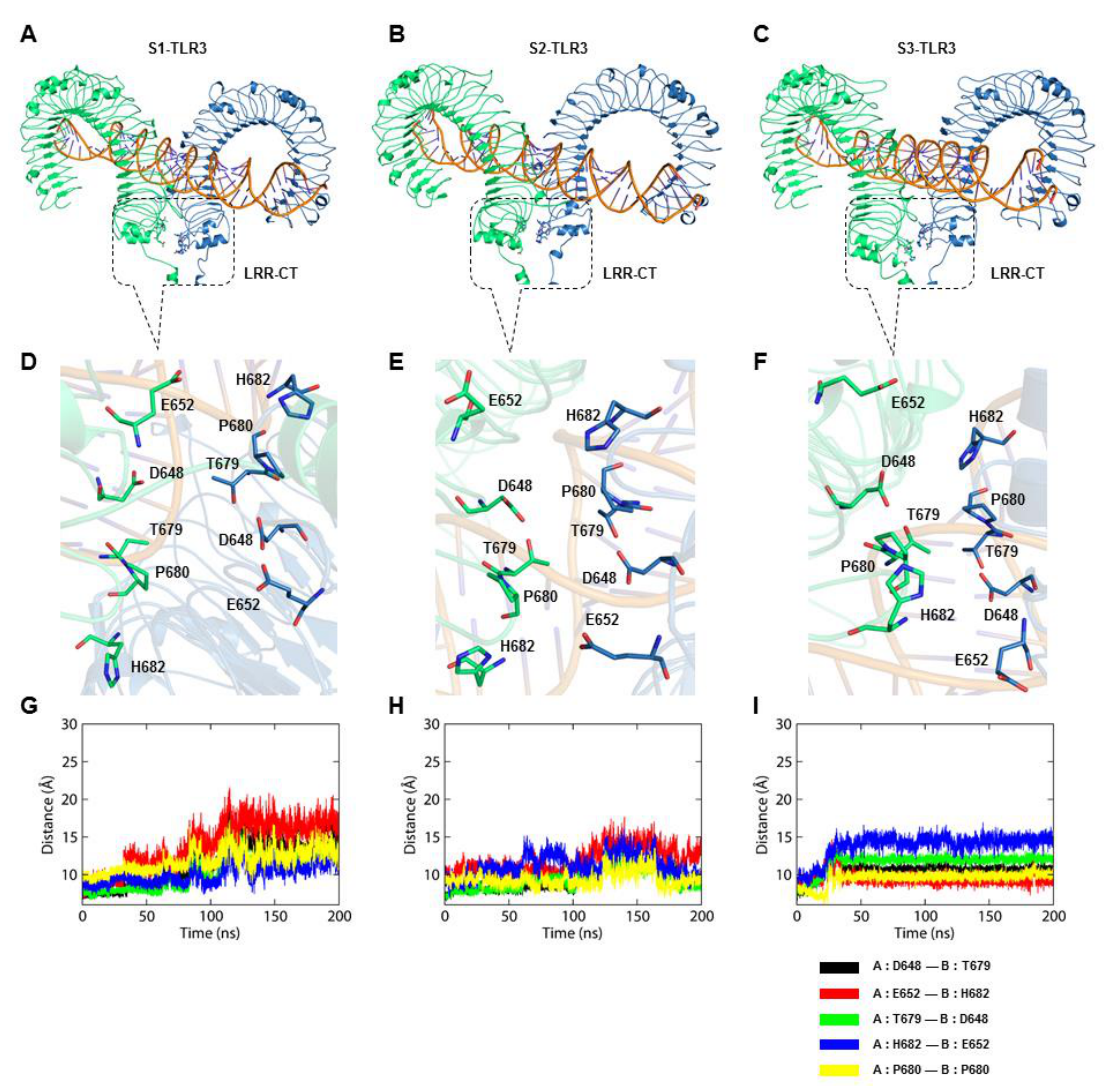
Figure 5. The homodimerization interface of TLR3 in the three representative MD simulation systems. ( A – C ) The overall structure of TLR3-ECD, showing receptor dimerization at the interface of the C-terminal subdomains. ( D – F ) Close-up view of amino acid orientations at the homodimerization interface of S1-, S2-, and S3-TLR3. ( G – I ) Distance between the chiral carbon atoms of interfacing residues as a function of simulation time. S1, S2, and S3 represent second replicate of sets 1, 2, and 3, respectively. Subunits A and B of TLR3 are colored blue and green,